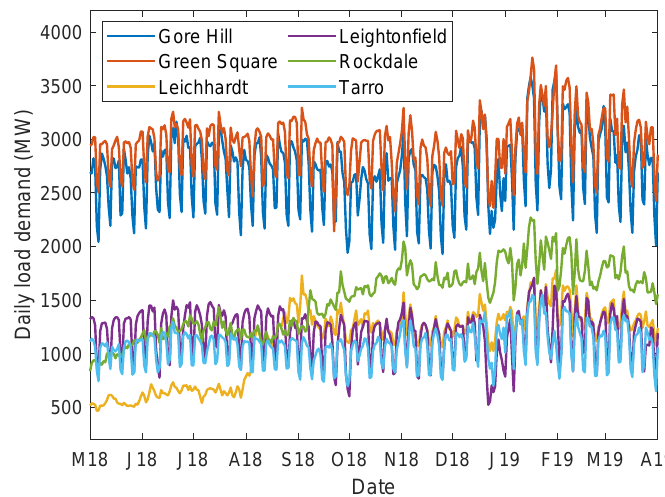
Figure 2. Daily load demand curves of six Ausgrid substations.